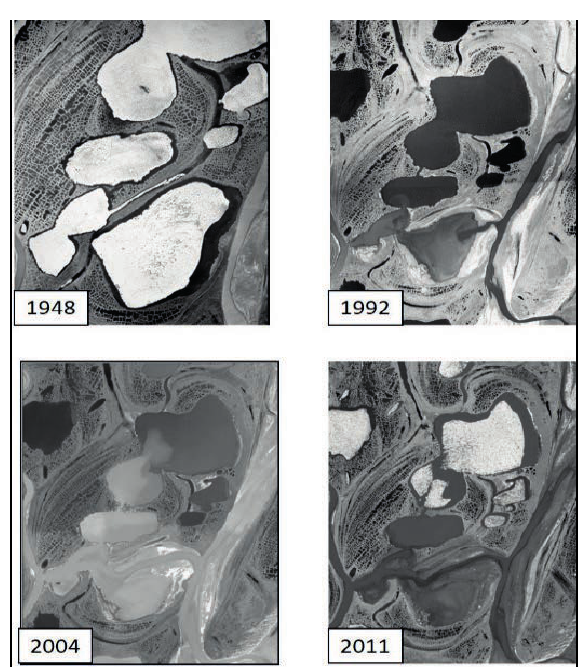
Fig. 6 Images of Lake 35 showing progressive tapping and